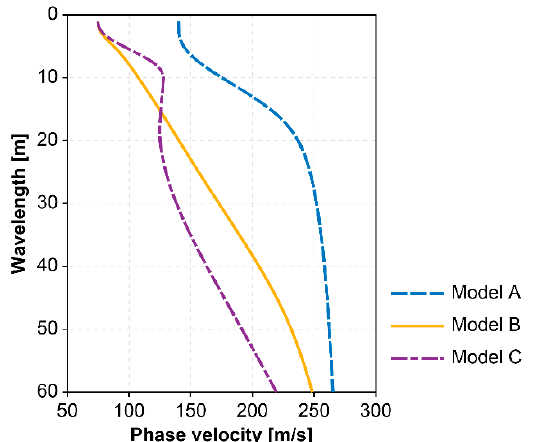
Figure 3. Fundamental mode dispersion curves for model A (two-layer model), model B (four-layer model with a gradual increase in stiffness with depth) and model C (four-layer model with a stiffer layer between two softer layers).